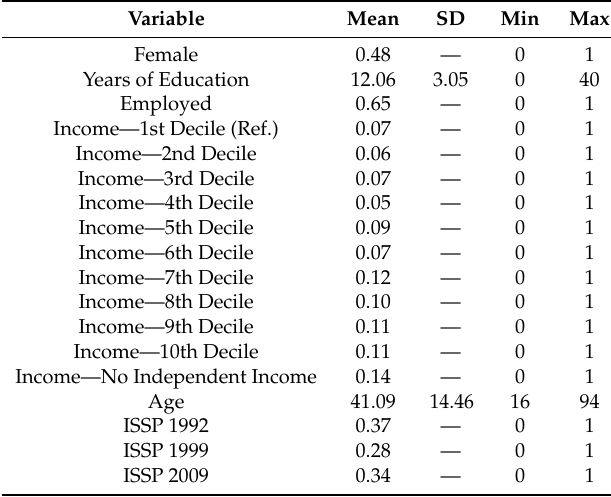
Table 1. Descriptive Table of Control